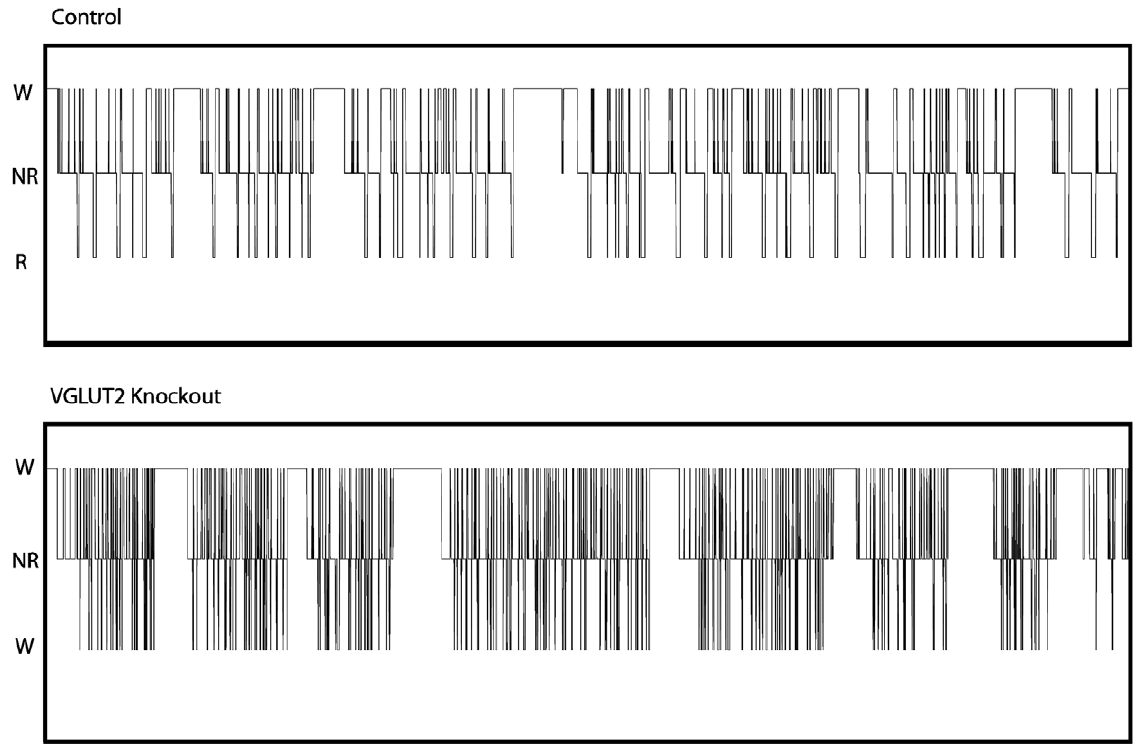
Figure 5. Stage changes of VGLUT2 knockout in the cLDT-SLD. Compared to a representative control animal (top), the mouse with VGLUT2 knockout (bottom) in the cLDT-SLD exhibits profound fragmentation in REM sleep, NREM sleep and wakefulness, and this is most evident during the light (rest) period (7:00–19:00).